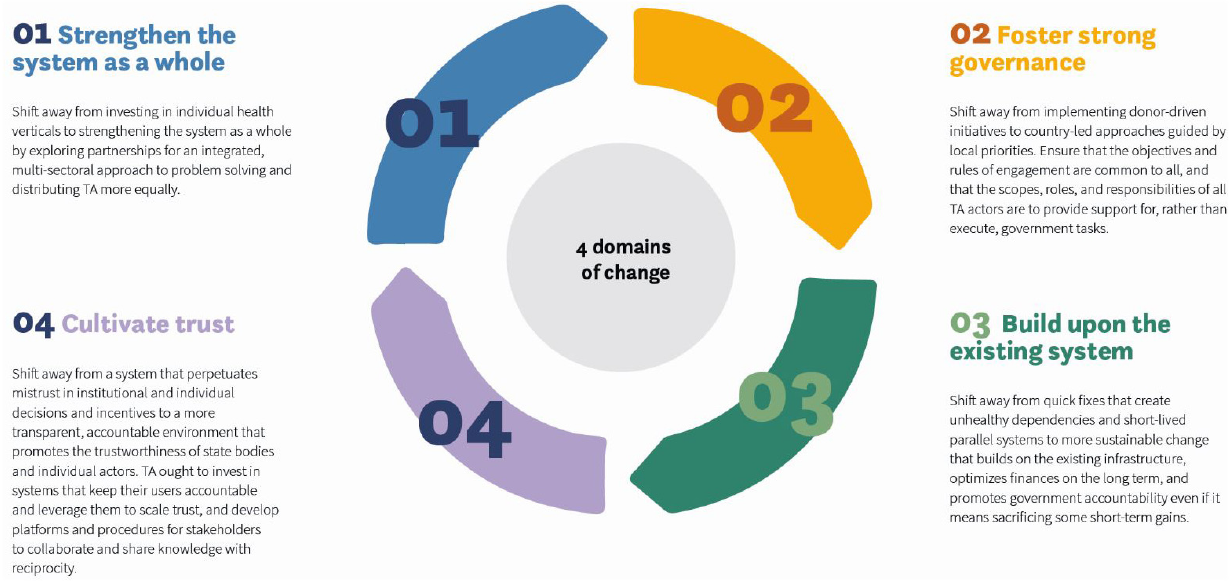
Figure 2. Four domains of change. Note: Has been reproduced with permission from Sonder Collective, 2020 22